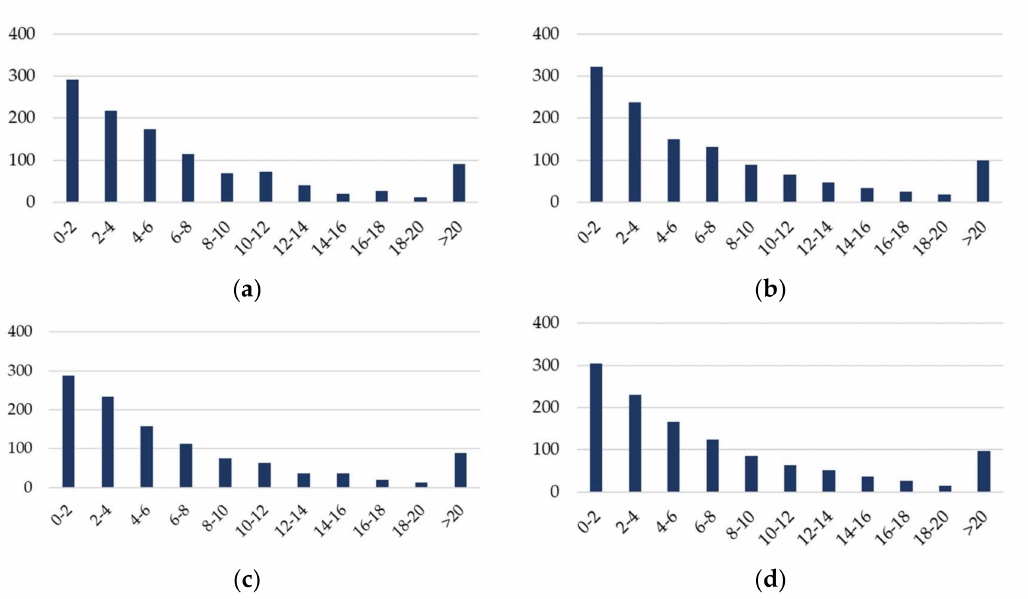
Figure 23. The number of hours during the year in which the increase in energy losses is within the defined ranges (kWh): (a) V3, (b) V5, (c) V8, and (d)